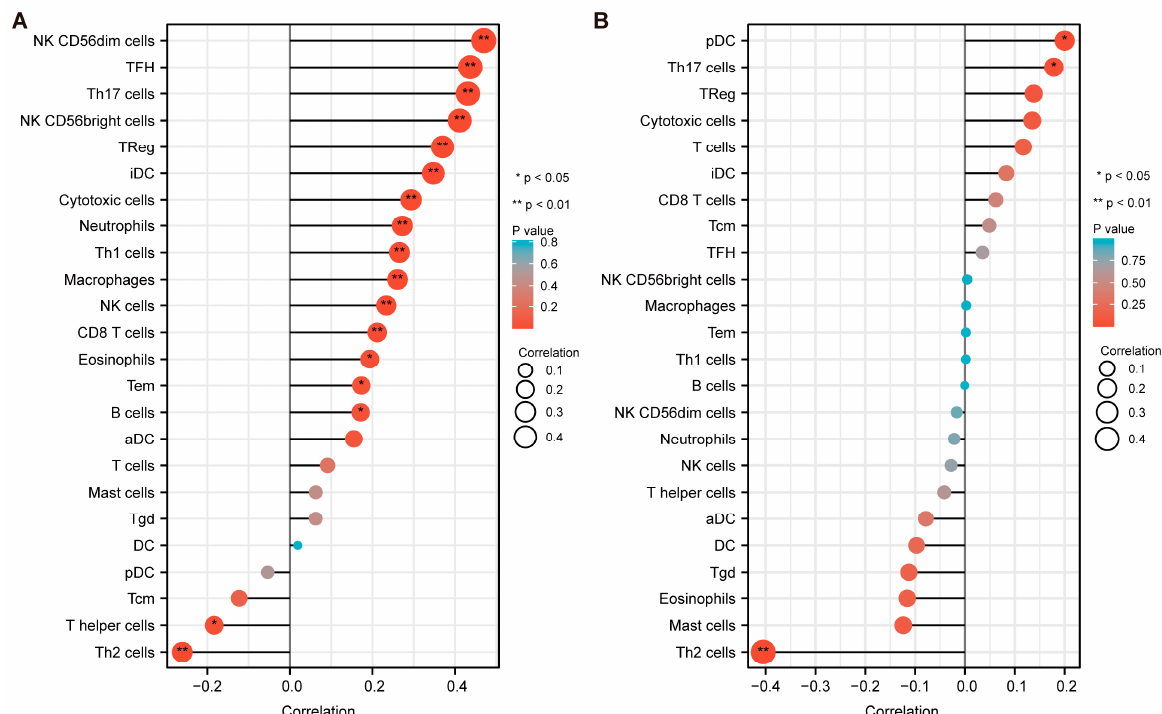
Figure 7. Immune infiltration analysis applying the “GSVA” package. ( A ) The relationship between MAPK3 and immune markers by Spearman correlation analysis. ( B ) The relationship between CD44 and immune markers by Spearman correlation analysis. The size of the dots indicates the absolute value of Spearman’s r. The larger the dot and the longer the bar, the higher the degree of correlation. * p < 0.05, ** p < 0.01.